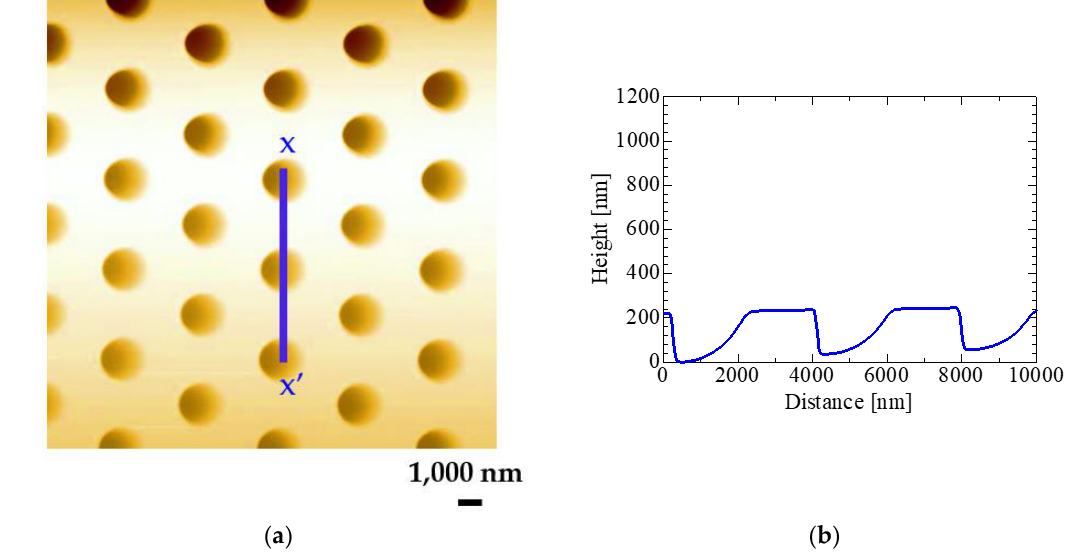
Figure 11. The nanohole patterns on a PET film mold after the transfer imprinting process; ( a ) the top view of AFM topography image; ( b ) the height profiles.